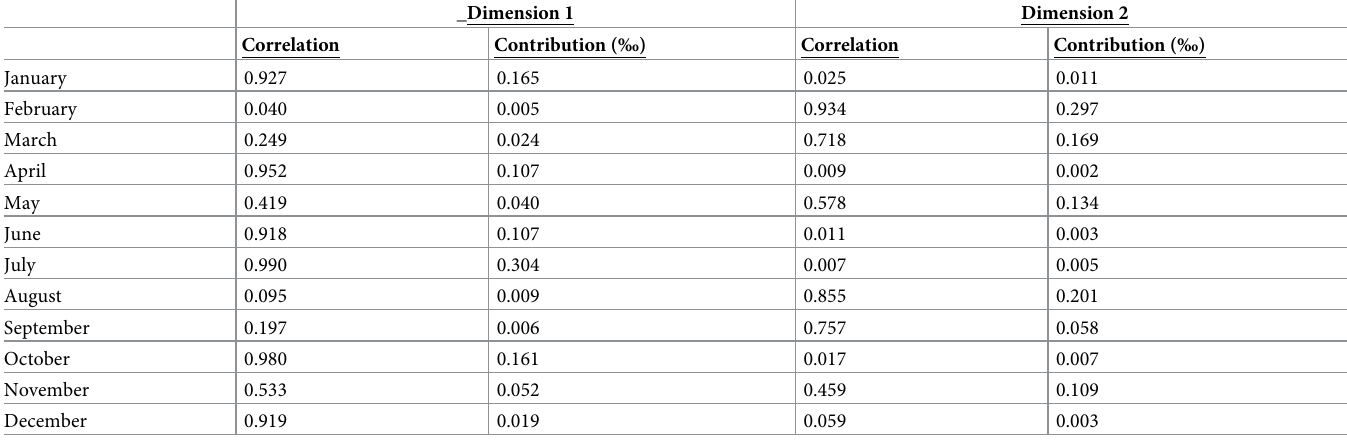
Table 9. Month correlations and contributions to correspondence analysis dimensions 1 and